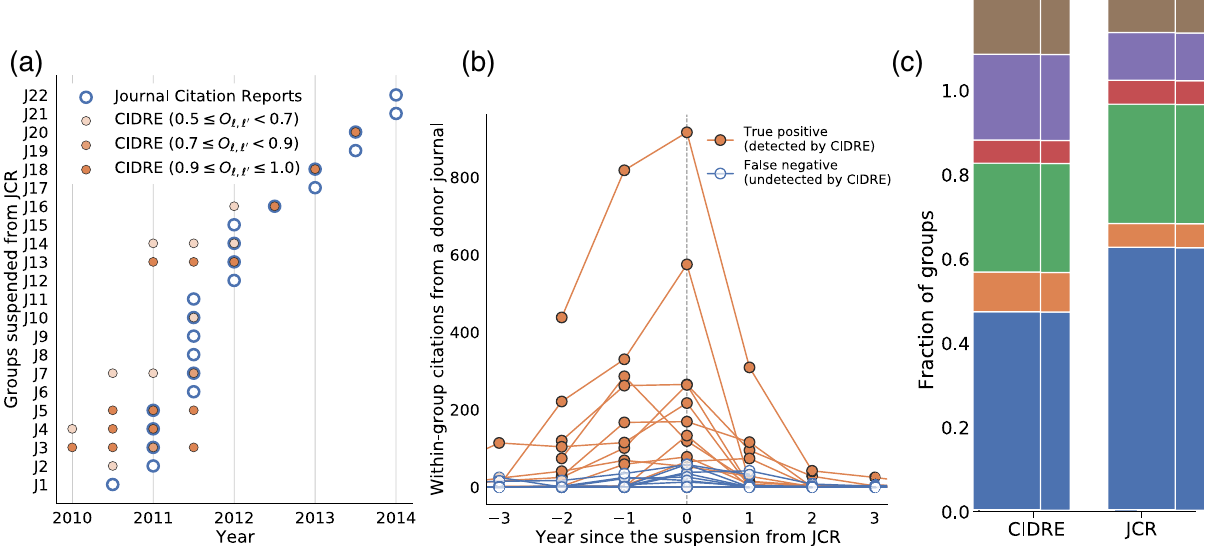
Figure 2. Overlap between journal groups identified by JCR and CIDRE. ( a ) Years when the journal groups are identified. The circles with thick borders represent the groups suspended from JCR. The filled circles represent those detected by CIDRE. The hue of the circles indicates the value of the overlap, O ℓ , ℓ ′ , i.e., the fraction of ′ journals in group ℓ detected by CIDRE that belong to group ℓ suspended from JCR. CIDRE detected 11 out of the 22 groups suspended from JCR in the year of the suspension or before. ( b ) Number of within-group citations per year from a donor journal excluding self-citations. If the group has multiple donor journals, we show the count for the donor journal that provides the largest number of within-group citations. The horizontal axis indicates the year relative to that in which the journal group is suspended from JCR. Therefore, a negative value indicates a year before JCR suspended the journal group. For groups J17, J19, and J22, the donor journals do not provide any within-group citations for the 3 years before the suspension. ( c ) Classification of journal groups identified by CIDRE and